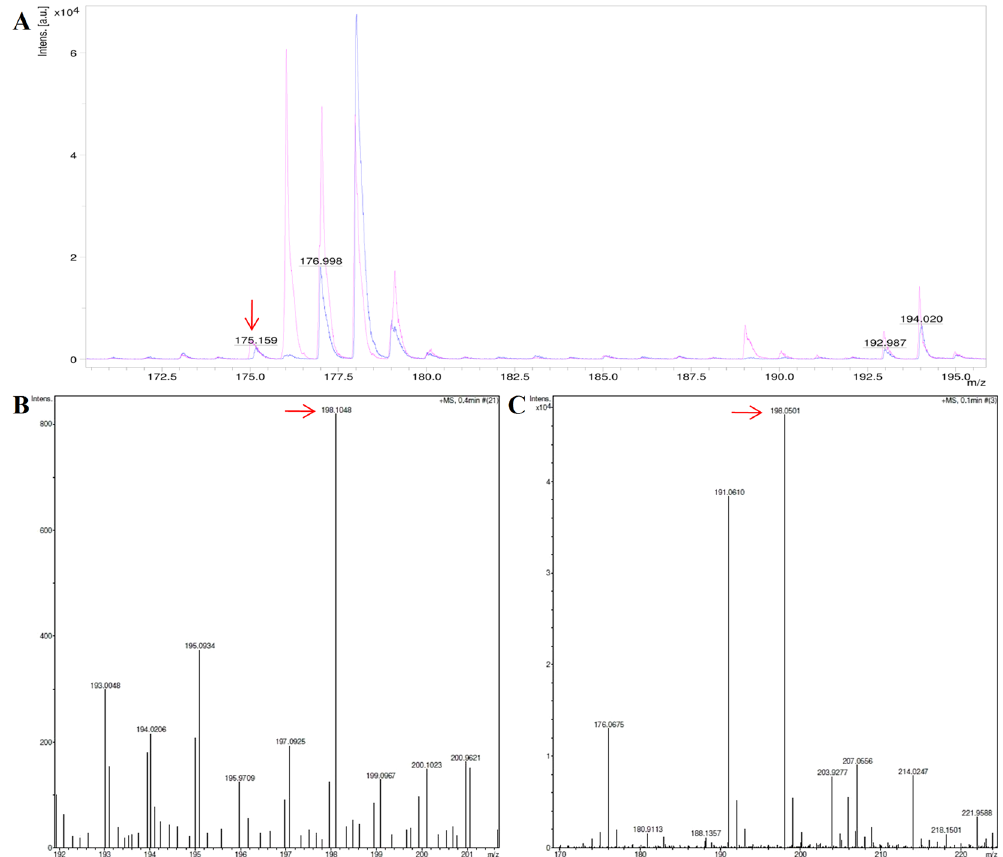
Figure 5. Ligand identification of by MALDI-MS and HRMS. ( A ) MALDI-MS spectra profile of pure Indole- 3-acetic acid (IAA) acquired from Sigma-Aldrich (magenta) and IAA obtained from denatured WTG sample (blue). The auxin (IAA) corresponds to a molecule with m/z = 175.15 (shown by red arrow). In addition, the spectrum also showed peaks in the low molecular weight range from 100–500 Da indicating peaks corresponding to the matrix ions. ( B ) HRMS profile of sample isolated from purified WTG wild-type protein. ( C ) HRMS profile of standard auxin. A peak at 198.10 corresponding to an m/z ratio of the IAA sodium adduct C 10 H 9 NO 2 Na [M + Na] + was obtained. The red arrow in B and C indicate the m/z ratio of the IAA sodium